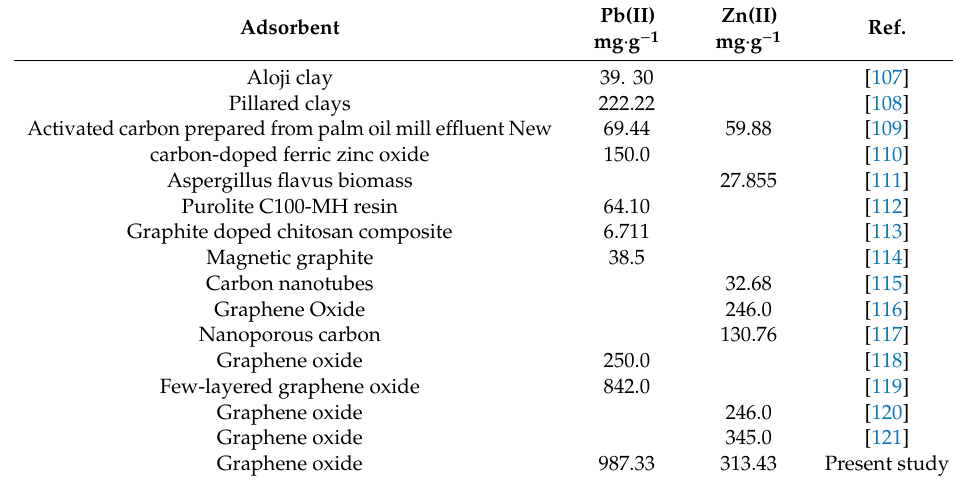
Table 4. Comparison of adsorption capacities with other adsorbents involving graphene oxide and other related materials.